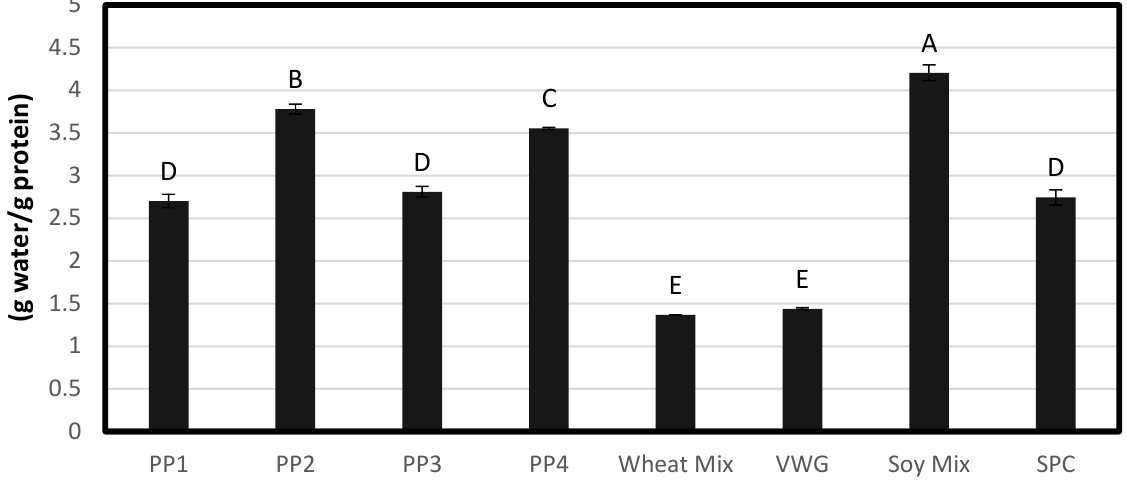
Figure 2. Raw material average water absorption capacity for all treatments. Bars denoted by the same letter are not significantly different ( p < 0.05).